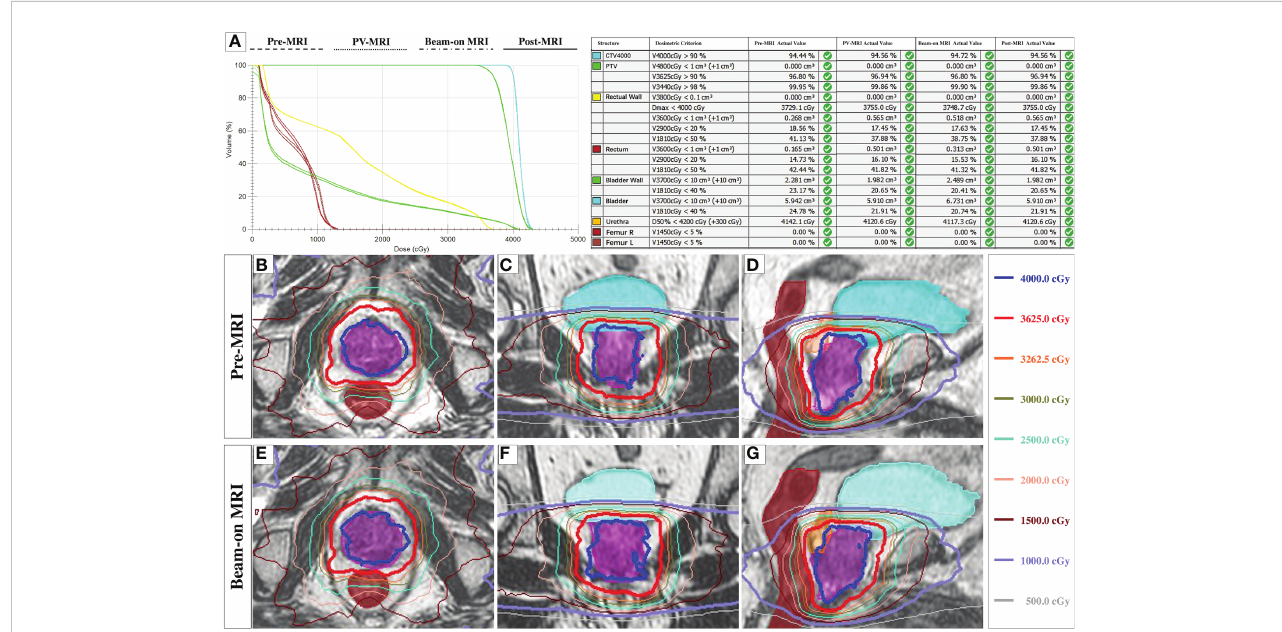
FIGURE 2 The dose distributions on each MRI scans. (A) : The representative DVH plot with four plans and the dose metrics on each MRI scans after re-planning in one fraction. (B – G) : The representative dose distributions of three planes of ATS plan on Pre-MR (B – D) and Beam-on MR scan (E – G)